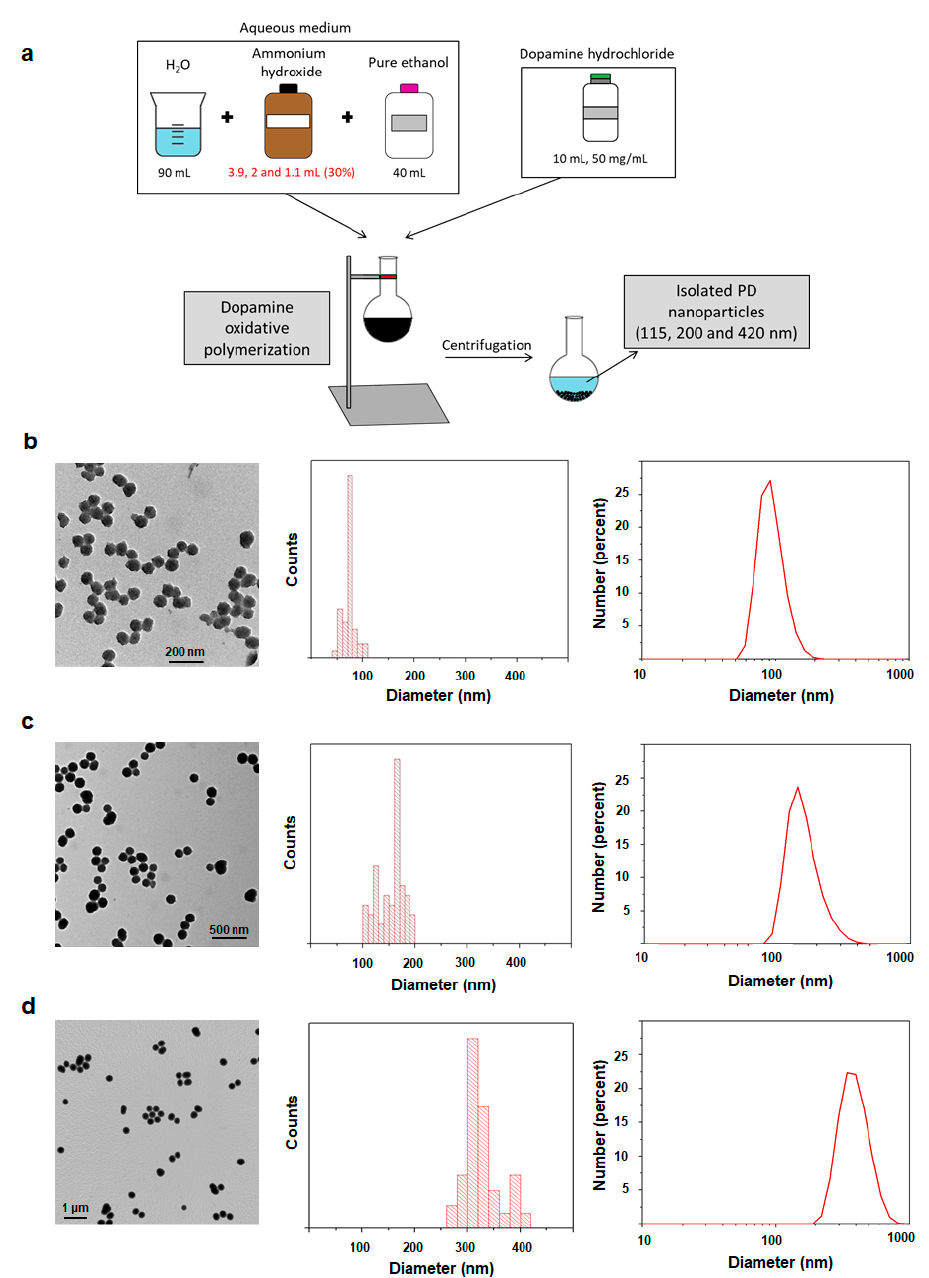
Figure 1. ( a ) Schematic representation of PD NPs synthesis by dopamine oxidative polymerization in a basic aqueous medium. ( b – d ) TEM images, size-range histograms and DLS number distributions of dispersions of PD NPs with three different diameters (pH = 7.0).